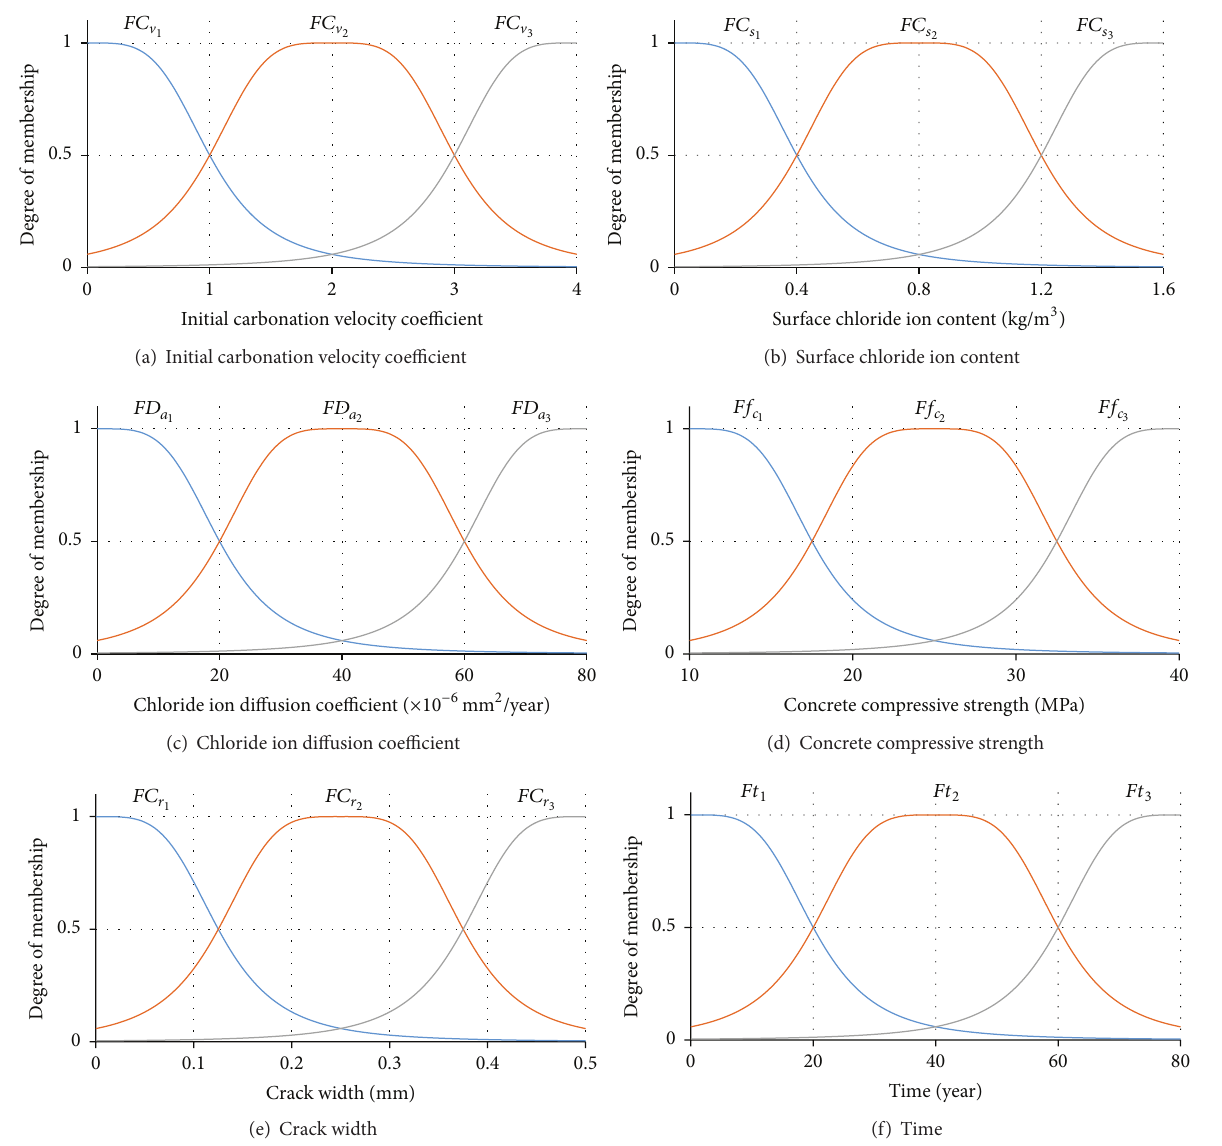
Figure 4: Fuzzy sets of input